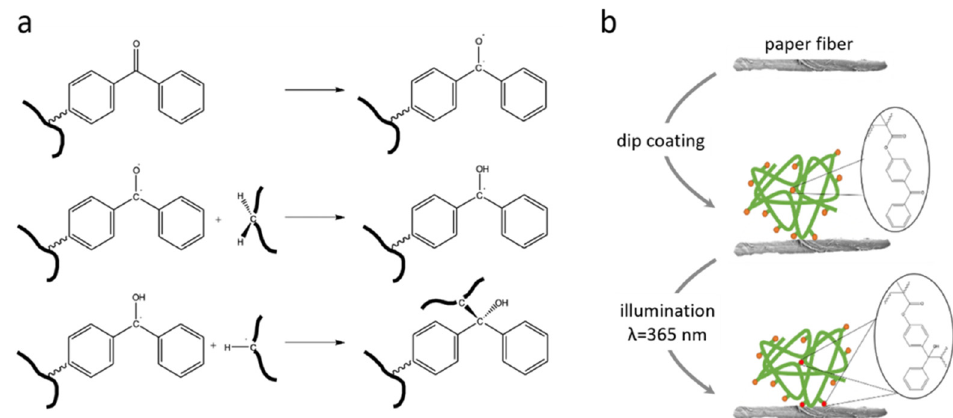
Figure 1. ( a ) Chemical mechanism underlying the crosslinking process. The excited MABP performs a C–H insertion with another molecule via a temporary triplet state. ( b ) Binding of a polymer chain to a cellulose fiber (not to scale), with the orange dots symbolizing unreacted MABP units and the red dots crosslinked MABP.